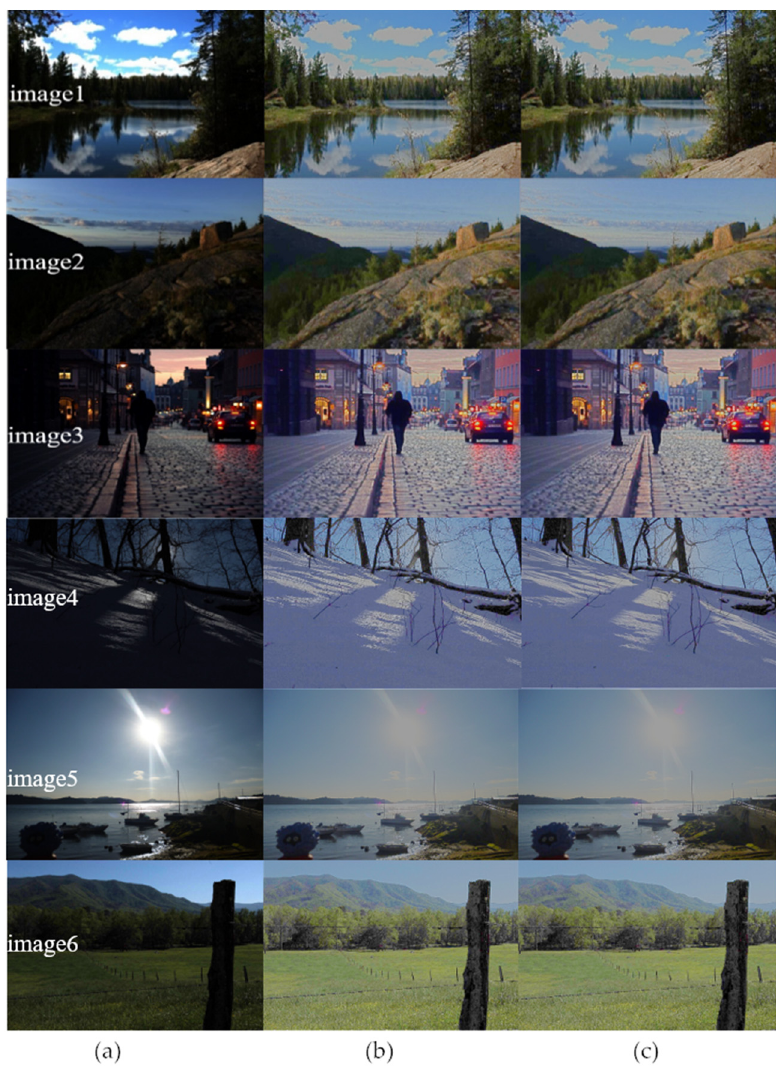
Figure 8. ( a ) Original image ( b ) Result of software processing ( c ) Result of hardware processing.